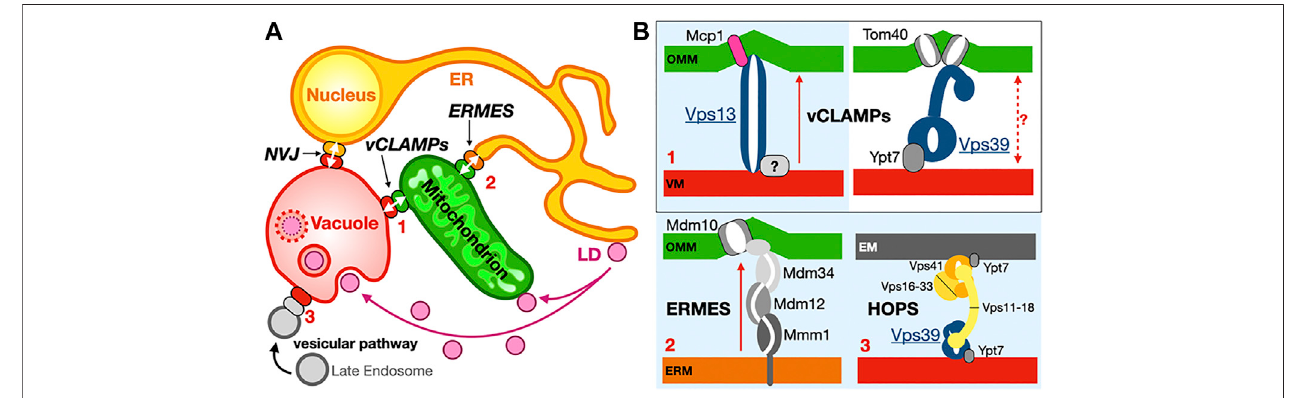
FIGURE 13 | Redundancy of membrane contact sites. (A) Overall schematic recapitulating the interconnectivity of organelles in the case of the ER (perinuclear ER included), mitochondria and vacuole implicating ERMES, vCLAMP and NVJ contacts sites. LD are connected to mitochondria and vacuole (shown here via lipophagy) whilethevesicularnetworkalsoconnectstothevacuolethroughaVps39-HOPScomplexredundanttotheVps13-vCLAMPandERMES. (B) TwodistinctvCLAMPsuse different subsets of proteins, Vps13 or Vps39, and respectively include proteins Mcp1 or porin Tom40 that could affect lipid desorption through membrane distortion although lipid exchange has not been associated with Vps39-vCLAMP . The ERMES, Vps13-vCLAMP and Vps39-HOPS pathways are redundant. Vps13 is also found at the NVJ under certain conditions. Complexes boxed in light blue constitute redundant pathways. Red arrows indicate lipid exchange activity.